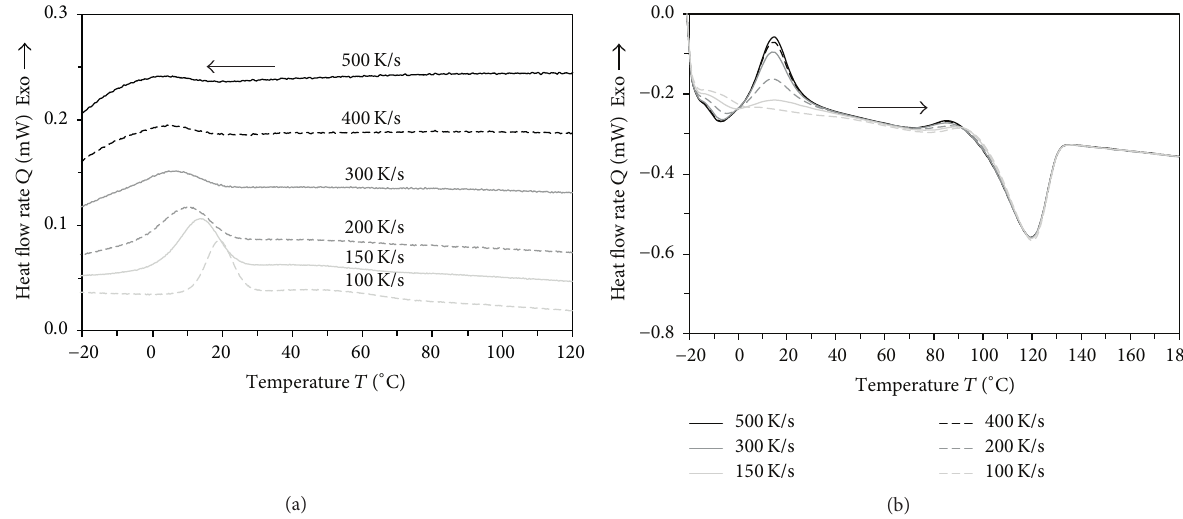
Figure 5: Heat flow rate measured during cooling (a) and second heating (b) of iPP with respect to the examined cooling velocities from 500 to 100 K/s.